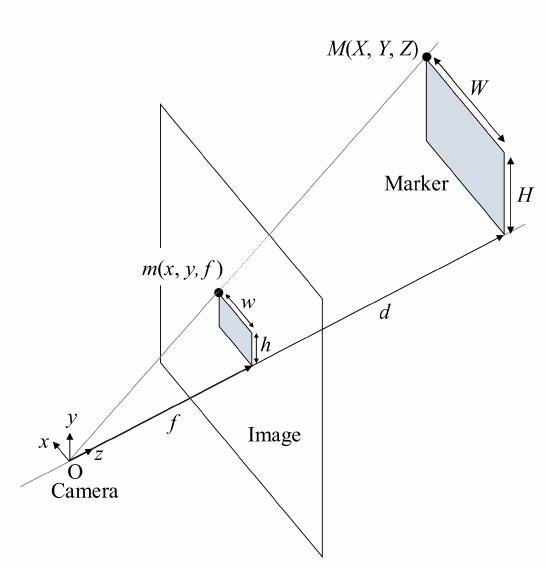
Figure 3. Relationship between camera, image, and